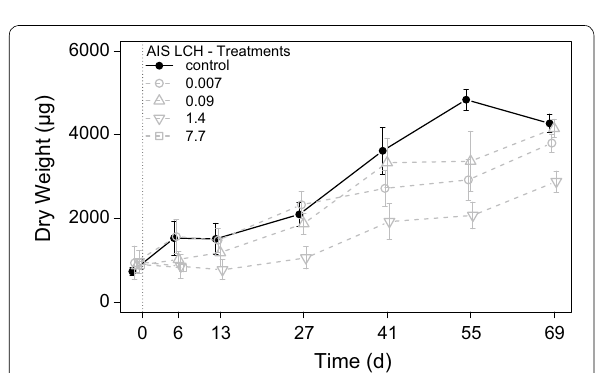
Fig. 10 Development of grazer dry weights during the LCH AIS experiment in the different treatments [mean treatments in µg g − 1 OC